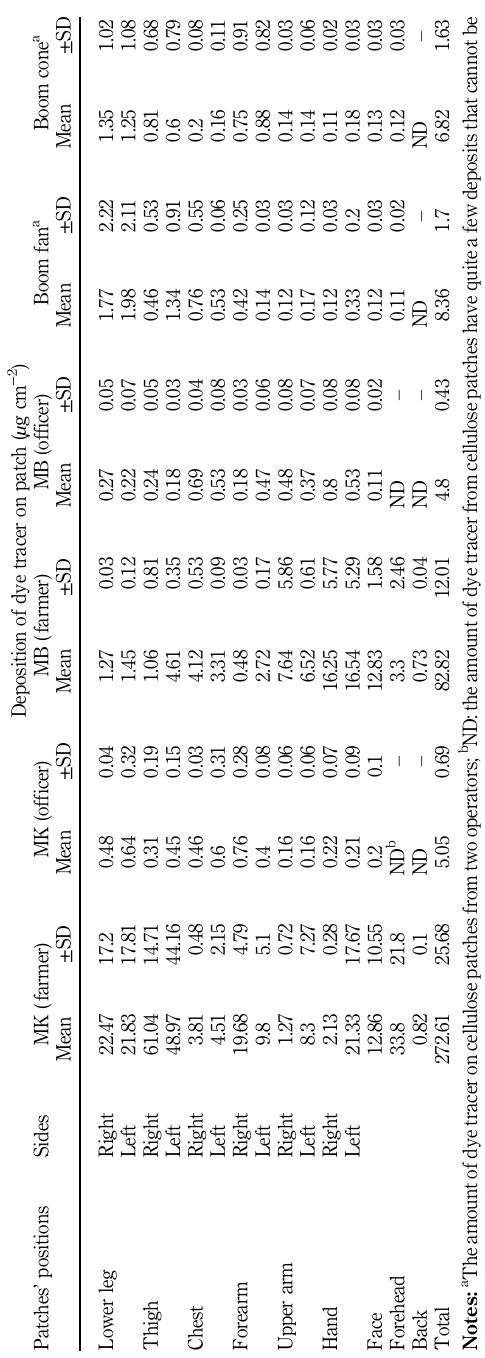
Table III. The deposition of dye tracer detected from cellulose patches: mean and standard derivations expressed as µ g cm − 2 on different spray application techniques (on rice at the booting